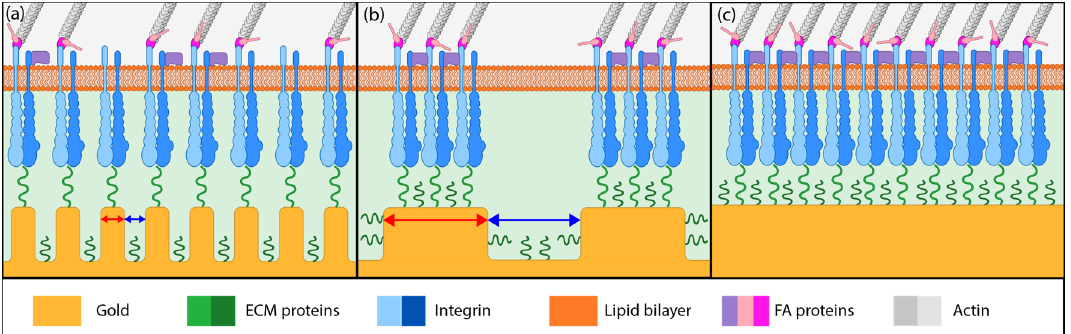
Figure 5. Illustration of different putative mechanisms of cellular adhesion onto coatings of various morphology. ( a ) On unannealed np-Au, integrin clusters may bridge multiple ligaments due to smaller pore widths but adhesive complexes cannot mature due to small ligament width (red arrows). ( b ) On annealed np-Au, integrin clustering is limited by the larger pore widths (blue arrows), limiting focal adhesion (FA) formation to individual ligaments. ( c ) On planar gold, FA maturation is uninhibited and FA size is large.